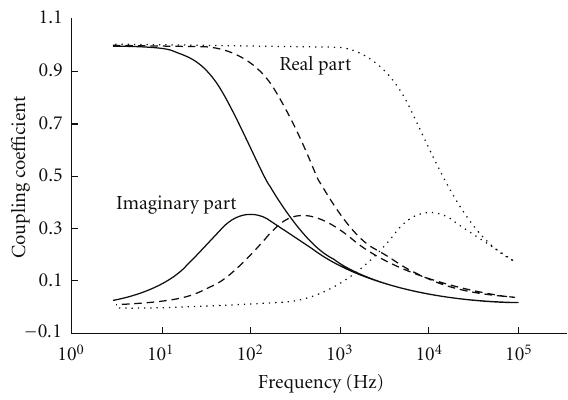
Figure 9: The real and imaginary part of Packard’s model (2) calculated by Reppert et al. [60] for three capillary radii: 100 μ m (continuous line), 50 μ m (dashed line), and 10 μ m (point line) (modified from